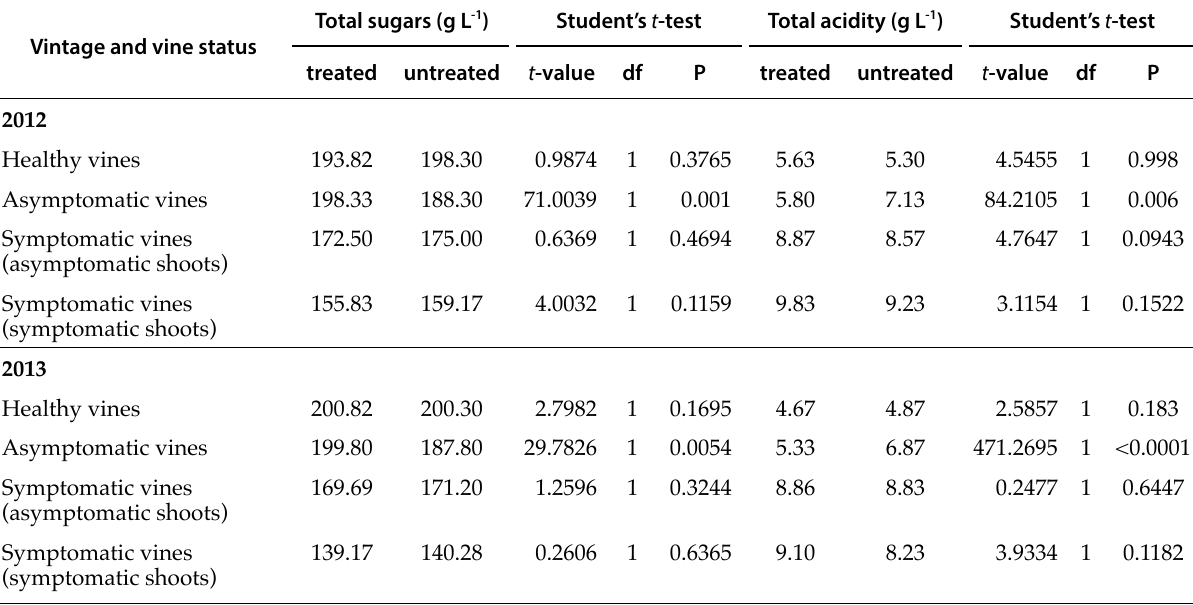
Table 2. Mean amounts of total sugars and total acids in berries from vines of different disease status (healthy, asympto - matic, symptomatic (asymptomatic and symptomatic shoots) at harvest in 2012 and 2013 growing seasons. In each status, the contents of total sugars and total acids of treated and untreated vines were compared by Student’s t -test. Total sugars (g L -1 Vintage and vine status